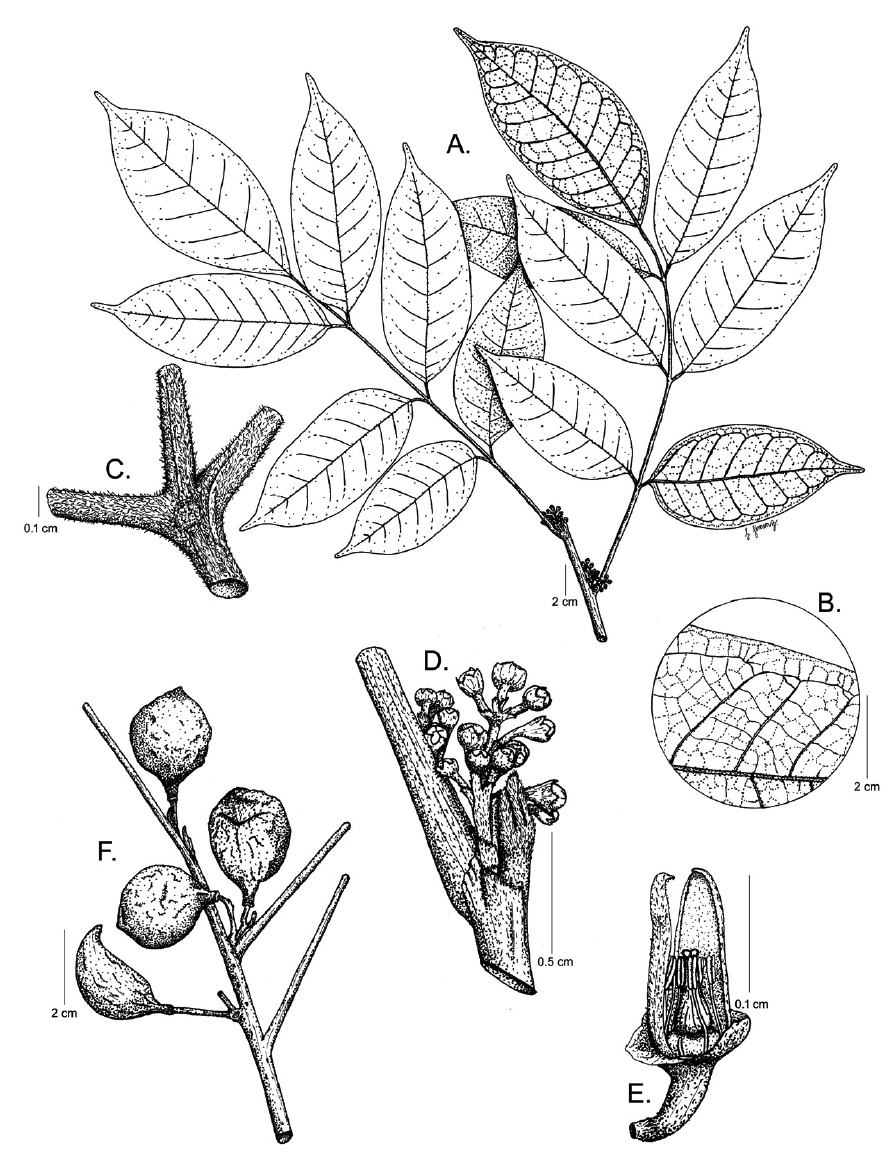
Figure 1. Protium aguilarii . A Branch with inflorescences B Venation C Pubescence on the leaf rachis and petiolules D Inflorescences E Female flower, with perianth partially removed F Fruits. A–D from R. Aguilar 4593, CR E from R. Aguilar & X. Cornejo 11115, CR F from K. Thomsen 226 , CR. Drawing by Jessica